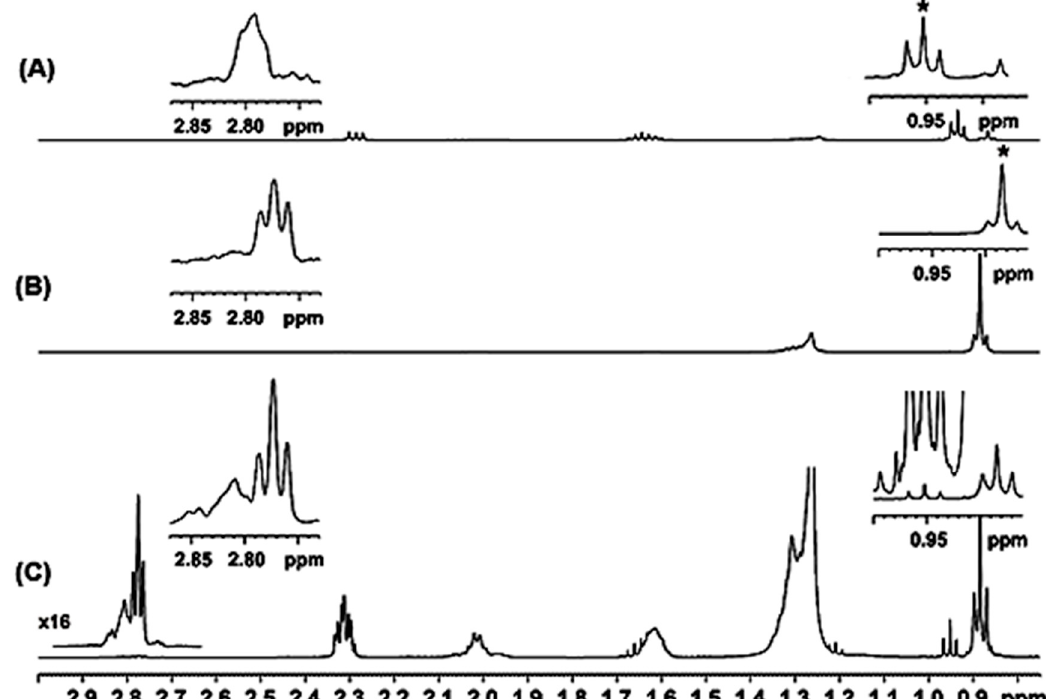
Figure 2. ( A ) Selected region of a 500 MHz 1 H-NMR spectrum of the lipid fraction of a lyophilized bovine milk sample in CDCl 3 ; T, 298 K; number of scans, 256; acquisition time, 4.3 s; relaxation delay, 5 s; total experimental time ~25 min. ( B ) and ( C ) 1D TOCSY spectra with τ m = 200 ms, number of scans, 256 and total experimental time ~25 min. The asterisks (*) denote the –CH 3 resonances that were excited with the use of a selective shaped pulse of 80 ms.